Question: What does this figure show? Answer in one sentence.
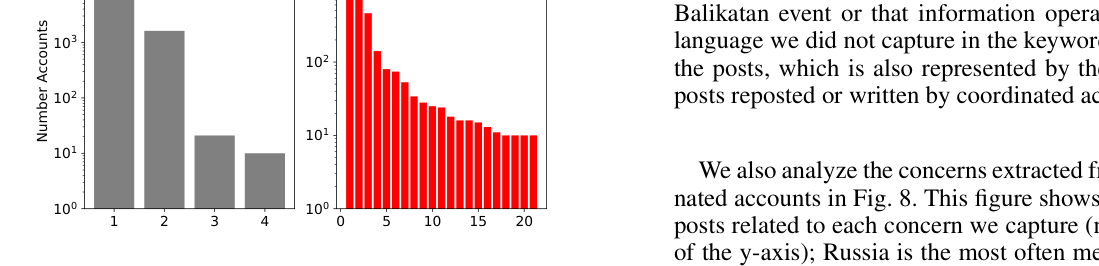
Answer: The number of coordinated accounts in each con- nected component (ranked by size). Accounts link with each other if they share the same long string of hashtags in each post. (a) 2022 French election and (b) 2023 Balikatan U.S.- Philippines military exercises.